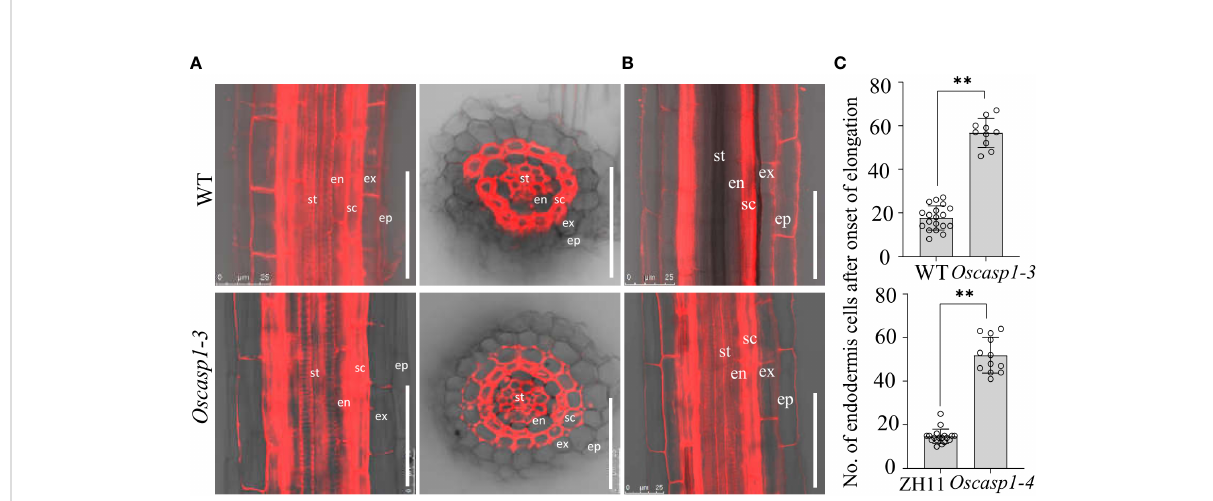
FIGURE 9 PI penetration in the Oscasp1-3 mutant and WT roots. (A) Representative images of Oscasp1-3 and WT SLRs showed the areas that lose barrier to PI in both of the mutant and WT. SLRs were incubated with 10 m g/ml PI for 10 minutes. (B) The area of WT SLR blocked PI penetration into stele. st, stele; en, endodermis; sc, sclerenchyma; ex, exodermis; ep, epidermis. Scale bar = 50 m m. (C) Quanti fi cation of PI penetration into the stele quanti fi ed as number of endodermal cells from the fi rst fully expanded cell in wild type. Student ’ s T-test was used for statistical analysis, and ** represents statistically signi fi cant difference (p value < 0.01); ns: no signi fi